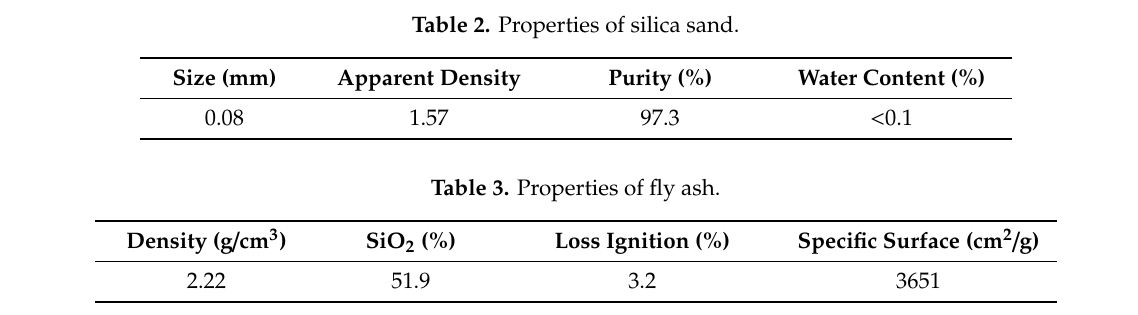
Table 4. Properties of silica fume.